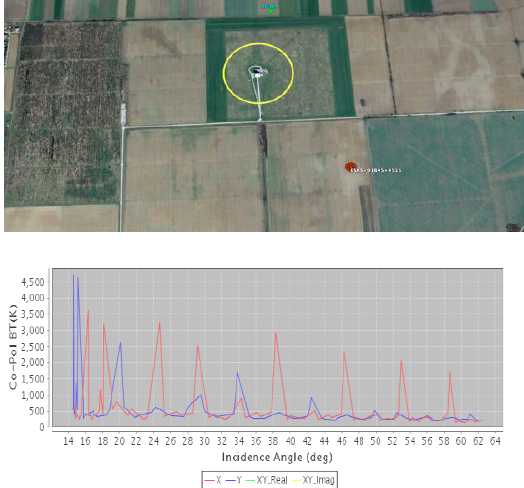
Figure 18. Interfering radar located by SMOS interference algorithms (left). Pulsed signal seen by SMOS in the time domain (right).